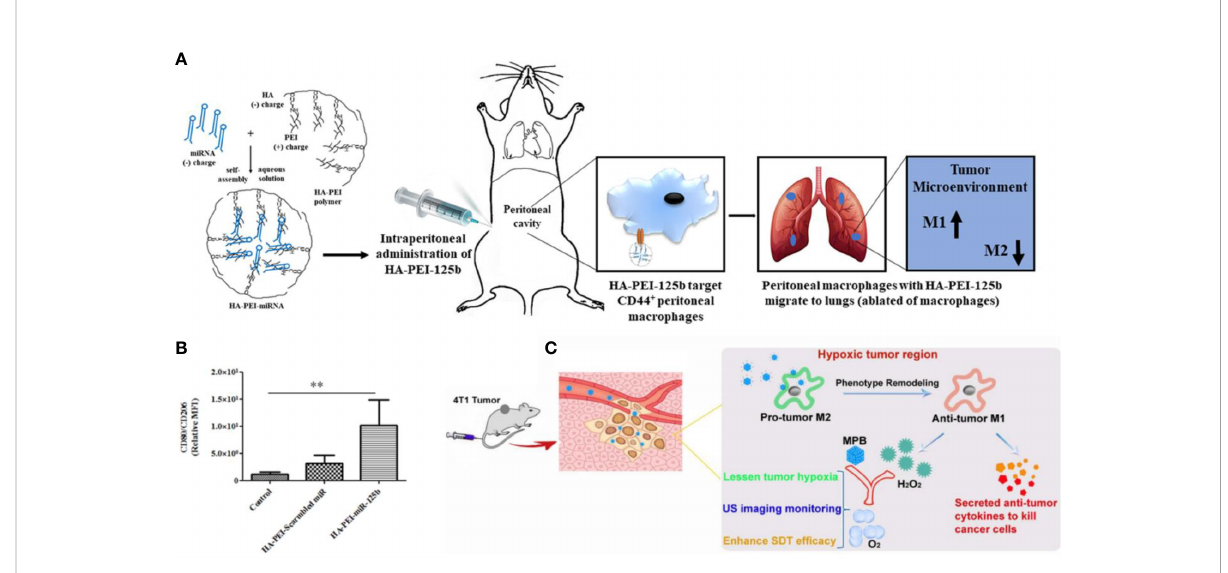
FIGURE 2 CD44 biomarker for TAM targeting and repolarization. (A) Assembly of HA-PEI and miRNA nanomedicine, which targets CD44 + TAMs to achieve a M1-phenotype repolarization. (B) Immuno-histochemistry of the lung reveals the proportion of CD80 + TAMs in TME. (C) LWM-HA fragments modi fi ed MBP nanomedicine effectively repolarize TAMs from M2- to M1-phenotype and produce oxygen to relieve tumor hypoxia. (A, B) were reproduced from ref (46); (C) was reproduced from ref